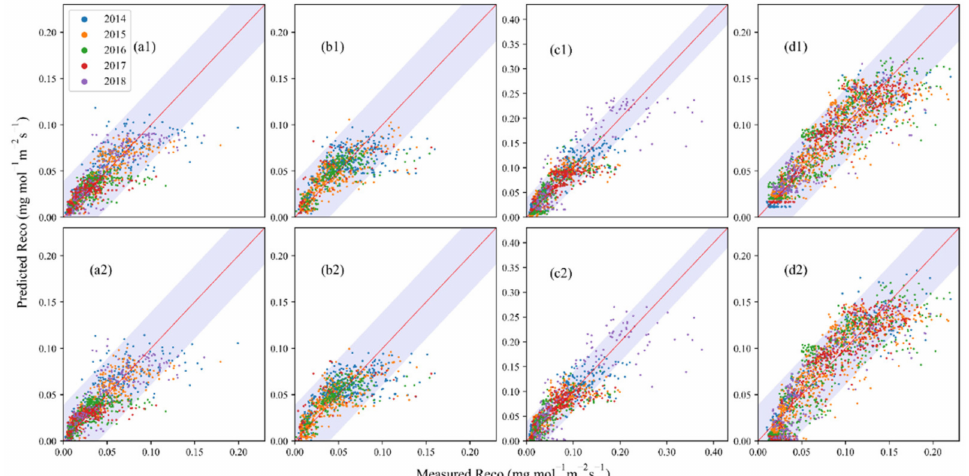
Figure 6. Performance of soil moisture–included models, including the Martin model ( a1 – d1 ) and the Concilio model ( a2 – d2 ) at four sites in different years. ( a1 – a2 ) are for SHB; ( b1 – b2 ) are for DRY; ( c1 – c2 ) are for TEMP; and ( d1 – d2 ) are for MDW. The time series model with six parameters ( α , β 0 , β 1 , β 2 , β 3 , β 4 ) includes DOY as